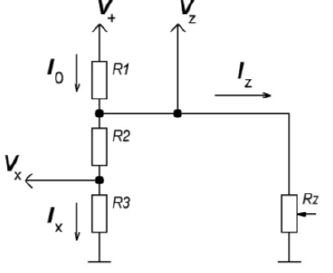
Figure 4. For the calculation of the ion sensor internal resistance, Rz.